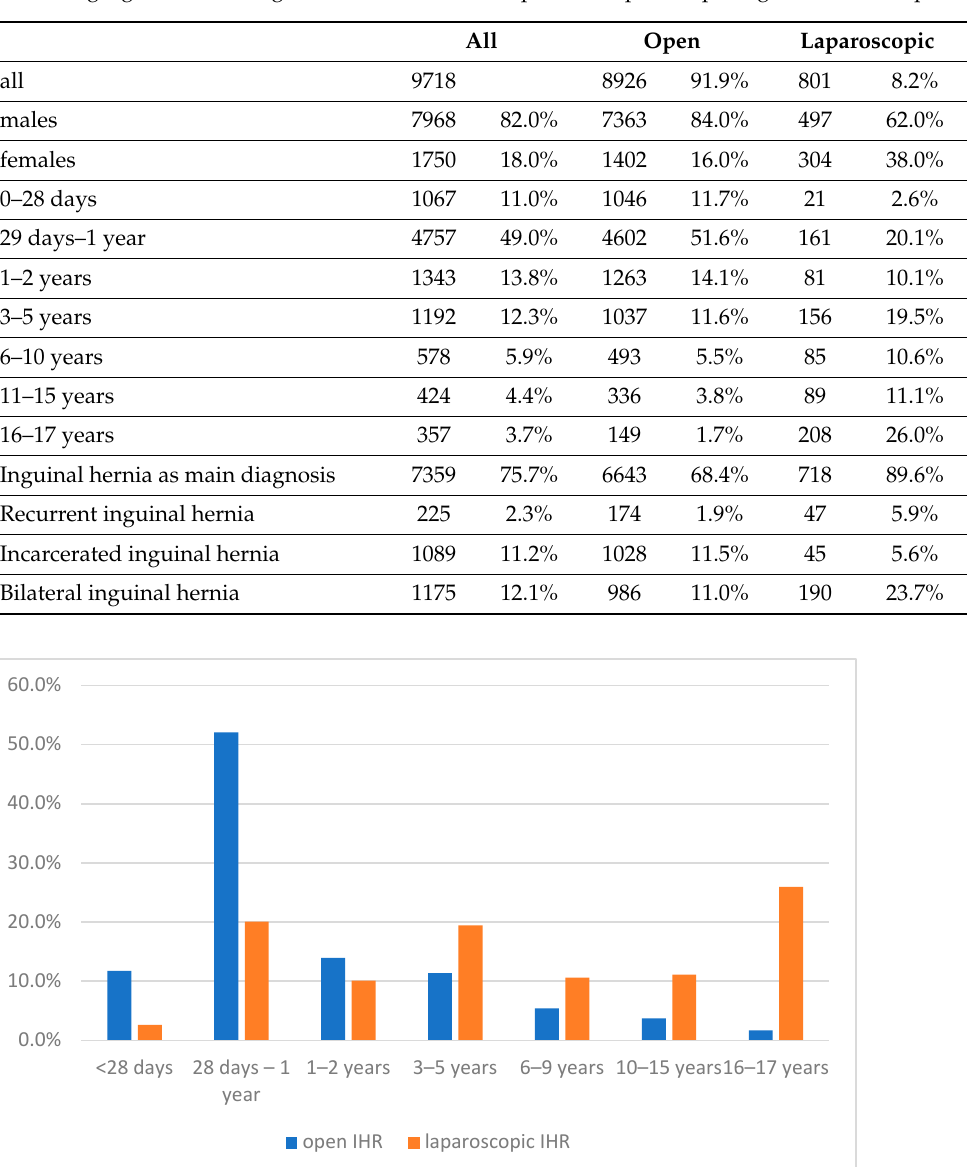
Figure 1. Distribution of age groups of children with open ( n = 8926) and laparoscopic ( n = 801) inguinal hernia repair.